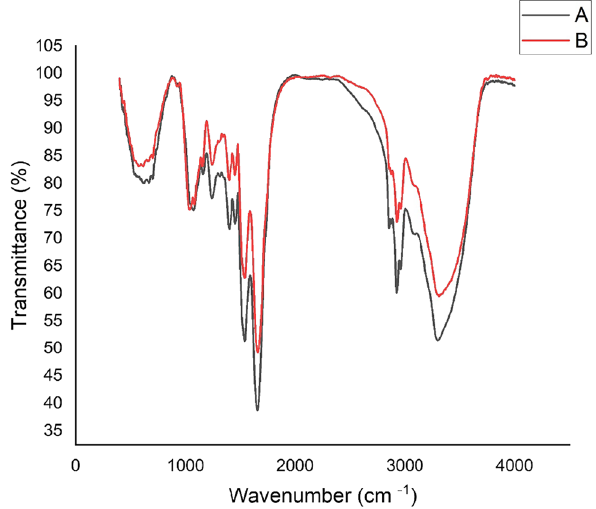
Fig. 1 FTIR Spectra of ( A) before and ( B) after MNZ